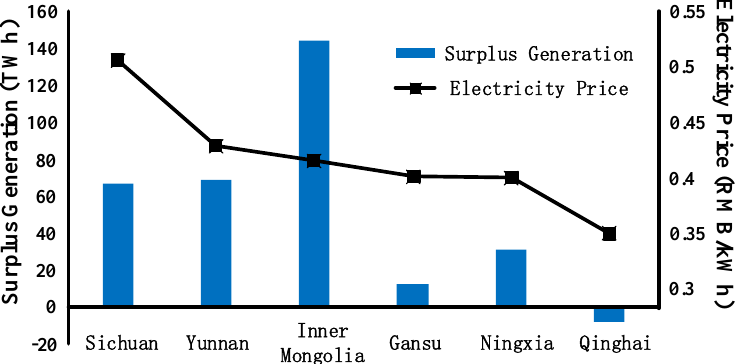
Figure 2. Electricity prices and surplus generation in some provinces of China.